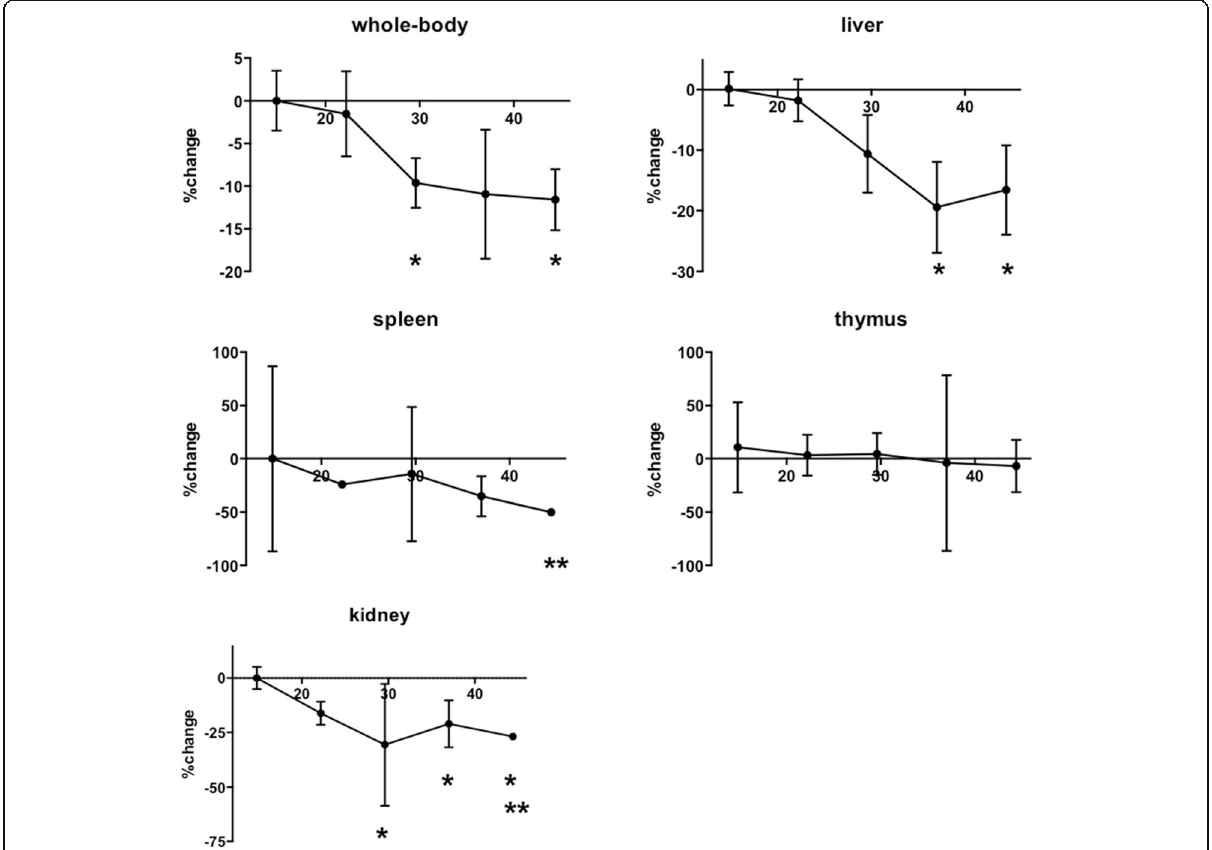
Fig. 13 Percent change relative to the 15-kBq-treated mice in the average whole-body and organ weights of tumor-free mice treated with 225 Ac-anti-PD-L1 (3 mg/kg, 60 μ g) at increasing administered activities of 15, 22, 30, 37, and 44 kBq ( n = 4 to 5 mice/point). * p ≤ 0.01 relative to